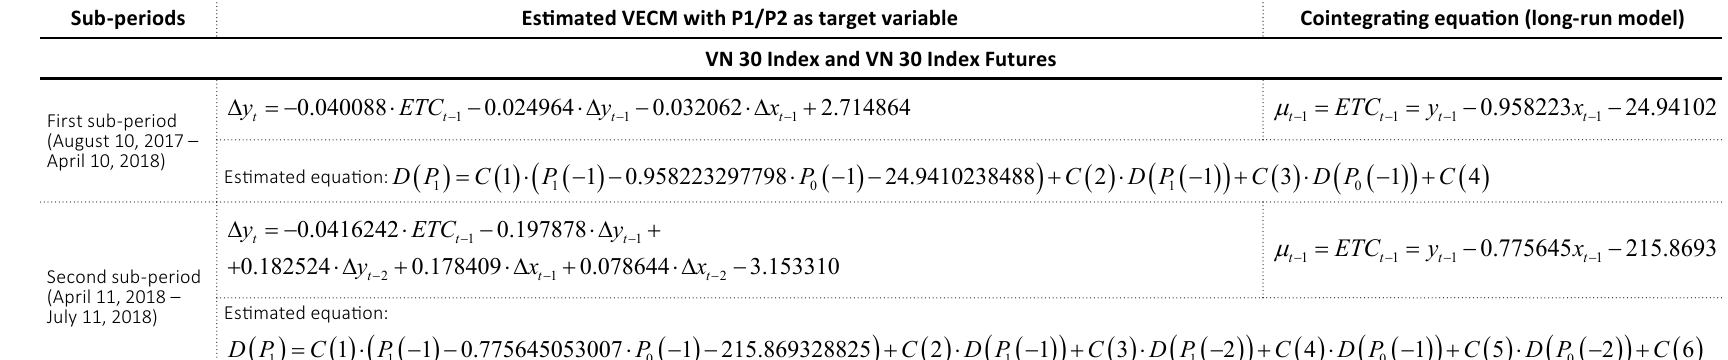
Source: Results calculated from EViews